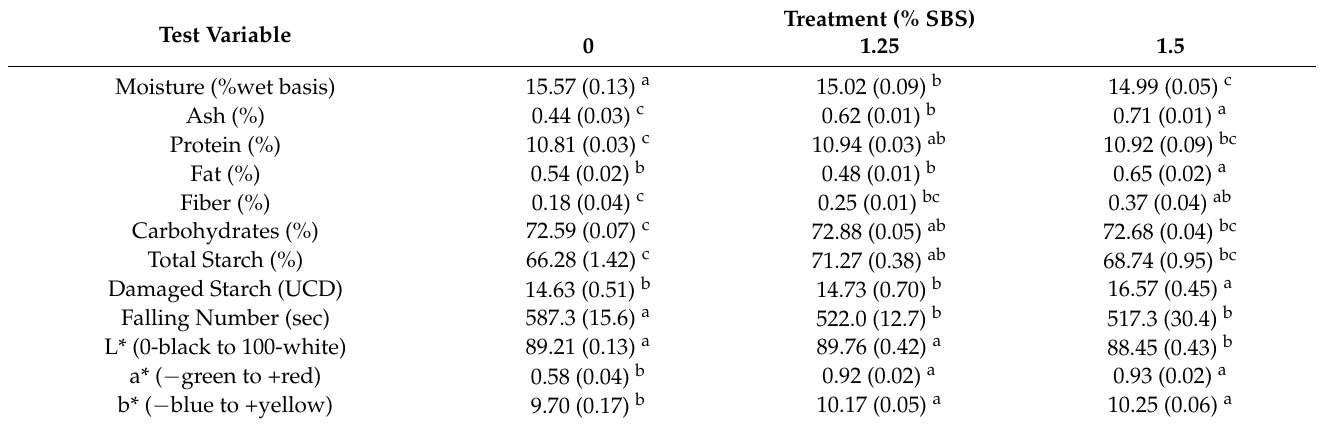
Table 4. Mean (sd) physico-chemical characteristics of wheat